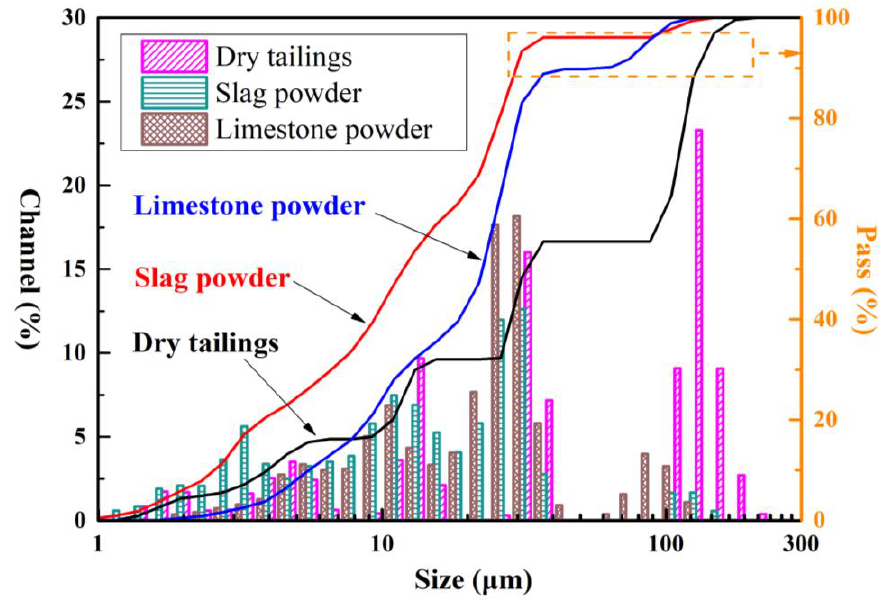
Figure 1. Laser-particle-analysis size-distribution curve of the raw materials.